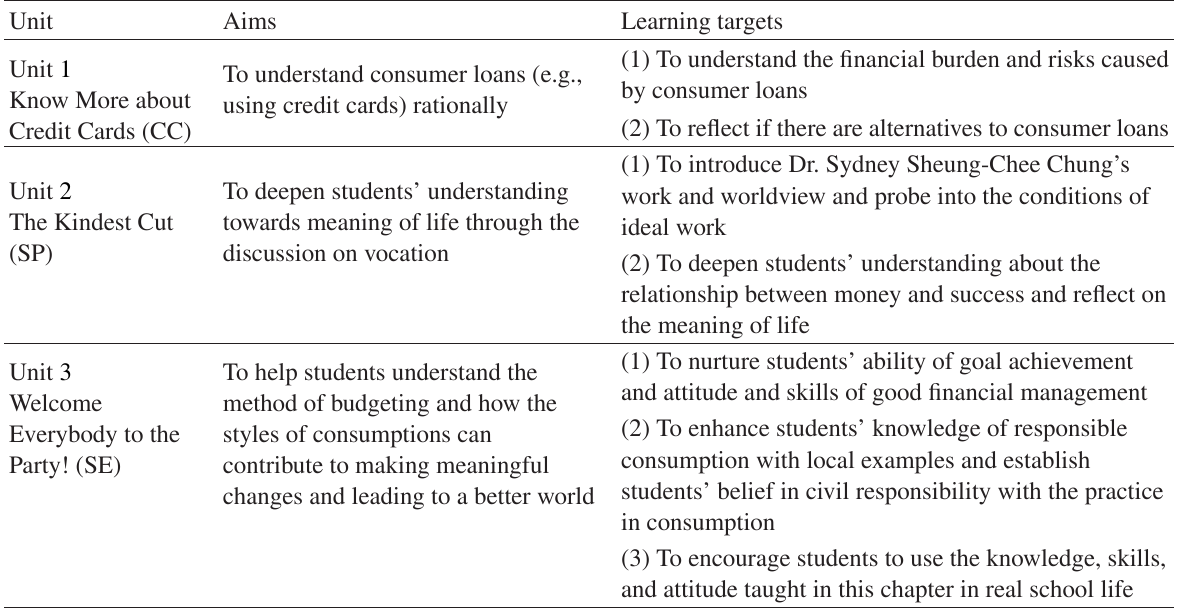
TABLE 2: Aims and learning targets of S3 P.A.T.H.S. (II) curriculum units related to “Money and Success.”